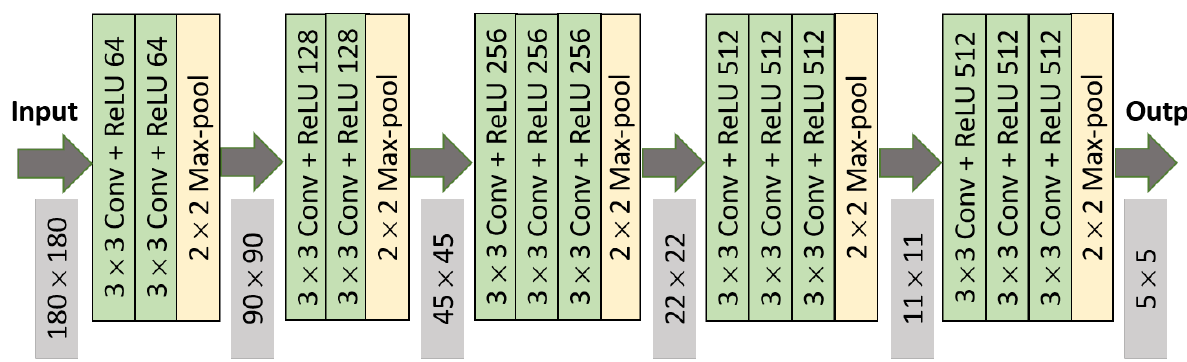
Figure 7. VGG16 architecture (excluding fully connected layers and 180 × 180 input image dimension).